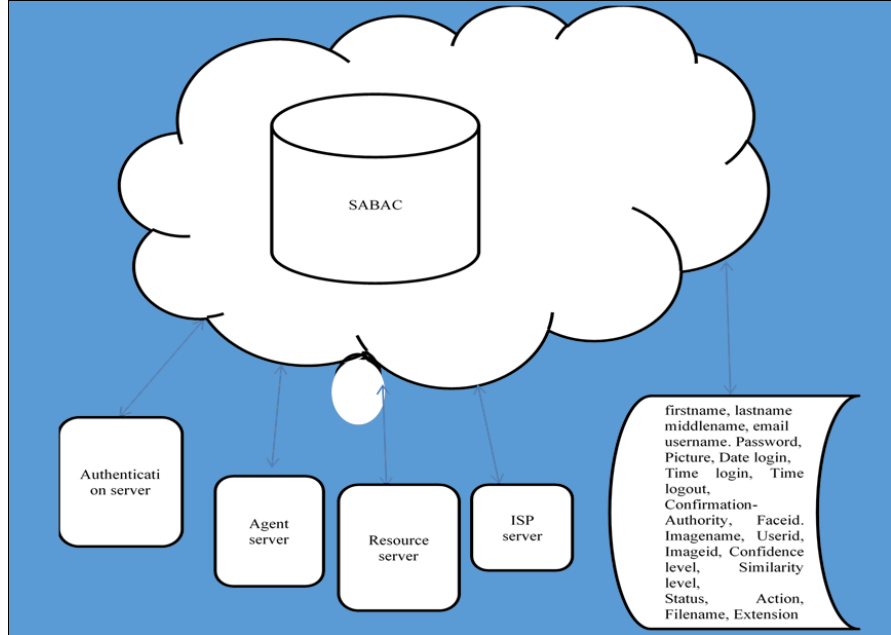
Figure 2: SABAC Database Archive. Source: Authors, (2021).